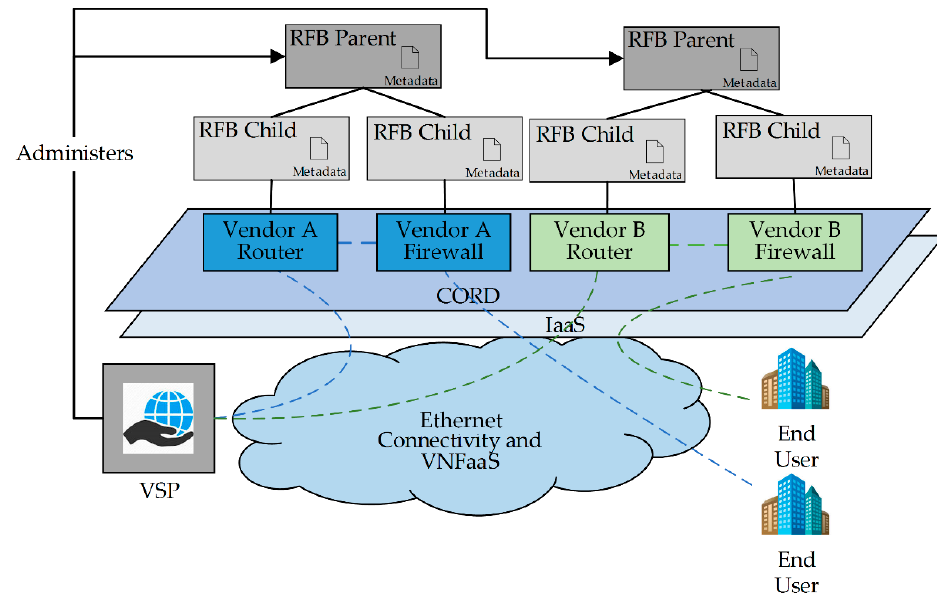
Figure 6. The Virtual Network Function as a Service use-case.